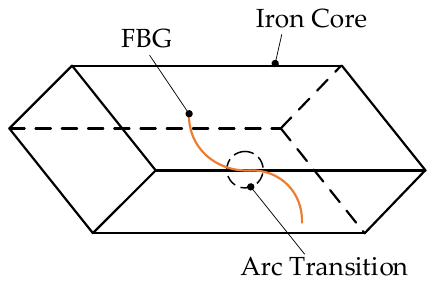
Figure 13. Wiring mode of FBG sensor at edges and corners.